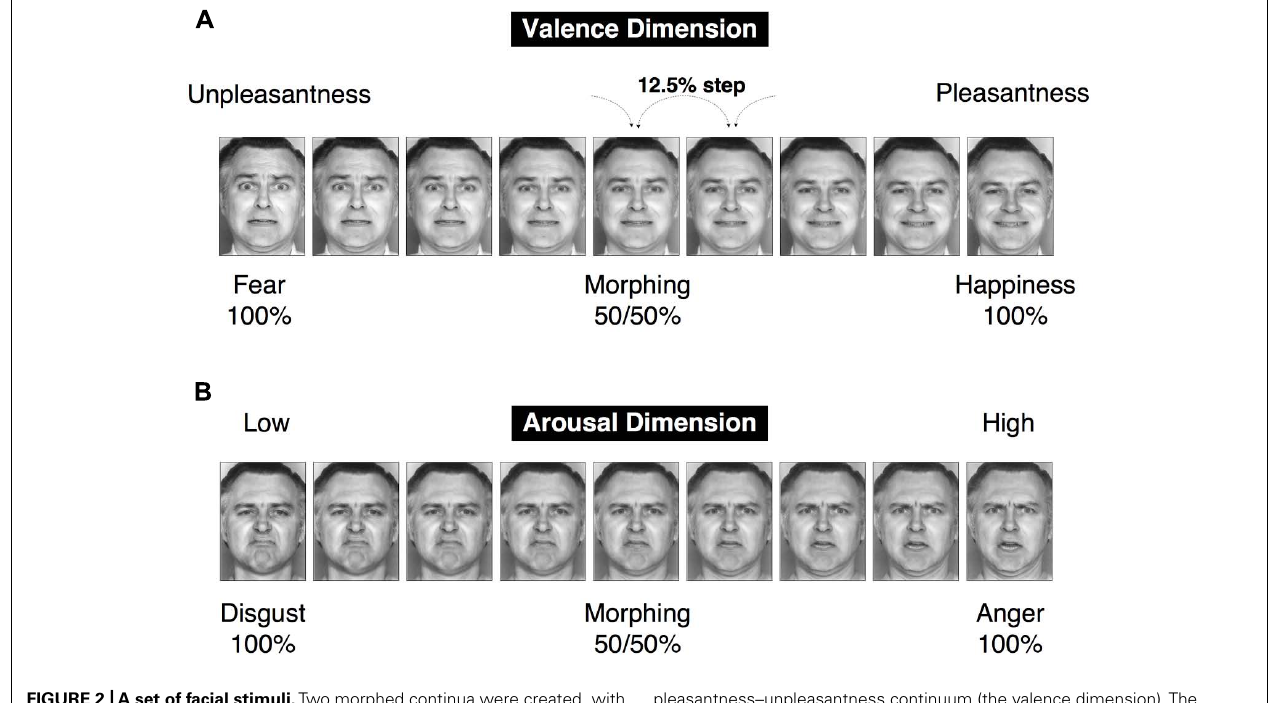
pleasantness–unpleasantness continuum (the valence dimension).The anger–disgust continuum represents change in the arousal–sleepiness continuum (the arousal